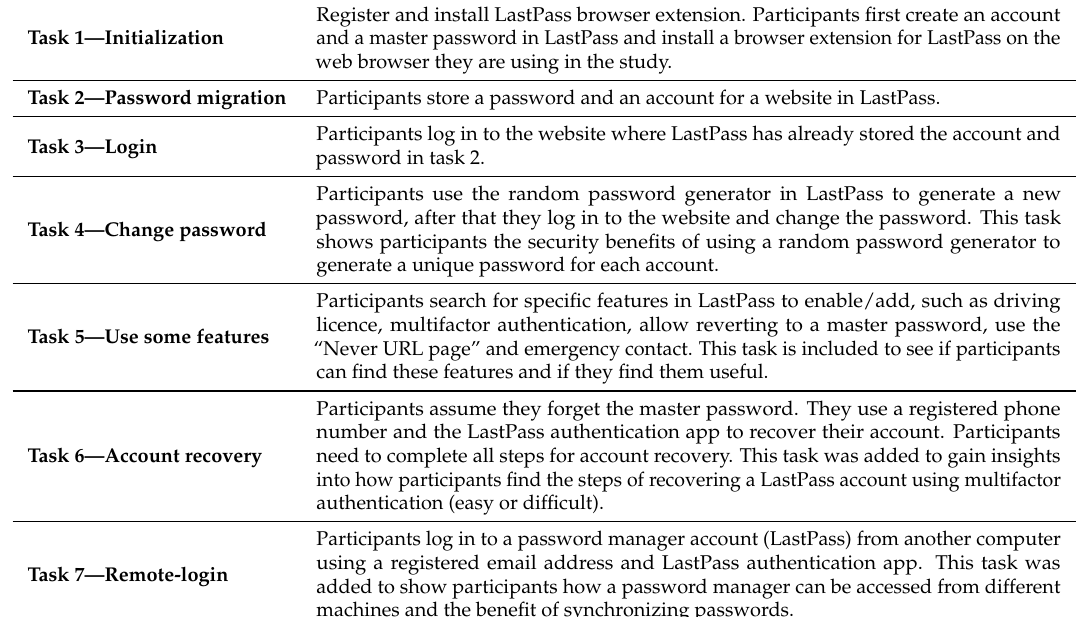
Table 2. Seven tasks that were applied in the usability